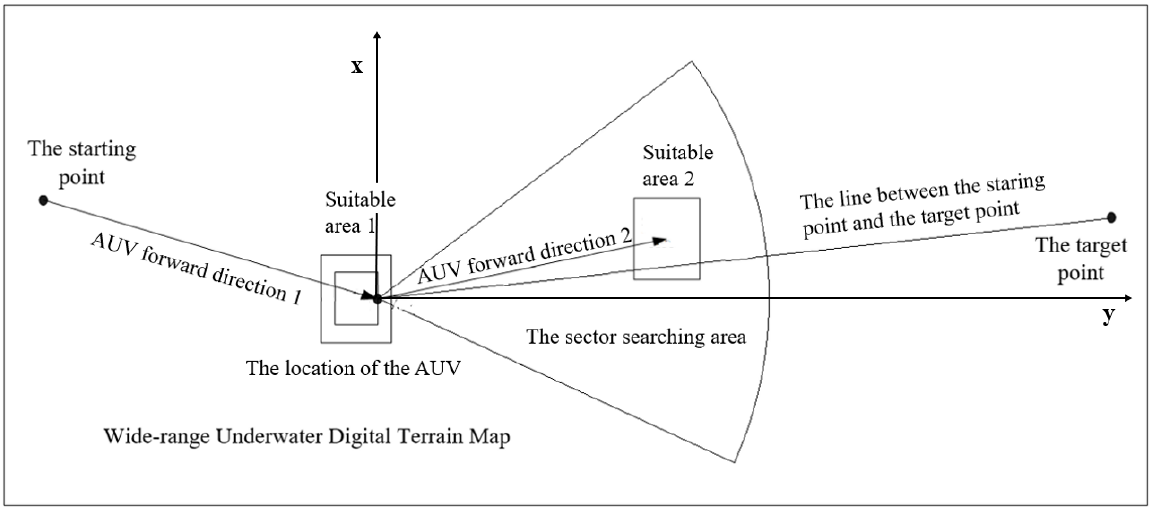
Figure 4. Sector searching at some time during the AUV mission.